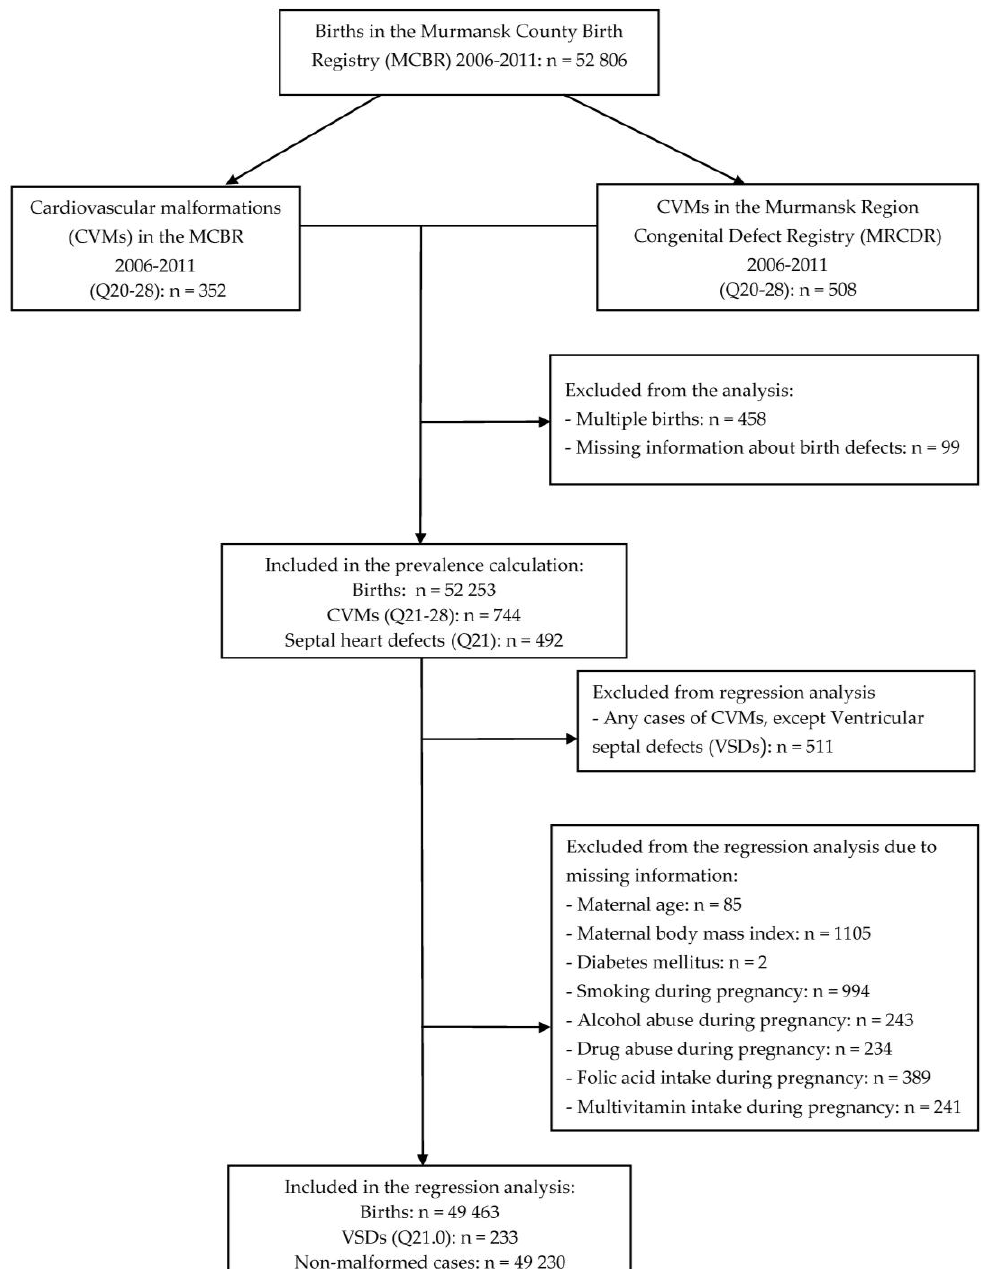
Figure 1. Number of births and exclusions for the combined Murmansk County Birth Registry and the Murmansk Regional Congenital Defects Registry 2006–2011 data. The individual numbers add up to more than the total number excluded because of missing information on two or more